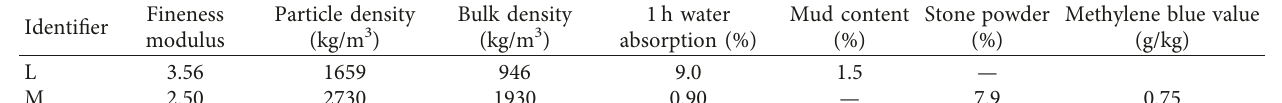
Table 1: Physical properties of lightweight sand and manufactured sand.